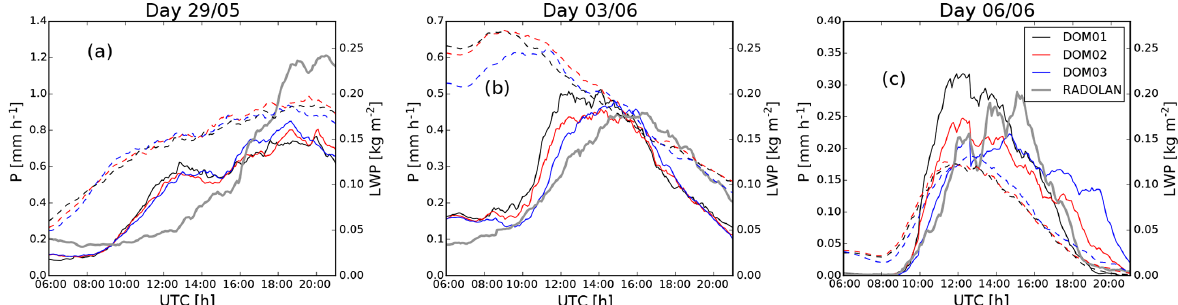
Figure 2. Time series of the mean precipitation intensity P (solid lines, left axes) and liquid water path LWP (dashed lines, right axes), for the 3d 29 May (a) , 3 June (b) , and 6 June (c) , for all three domains with 625m (DOM01), 312m (DOM02), and 156m (DOM03) grid spacing. The gray thick line shows the RADOLAN derived precipitation intensity. Averaging was carried out over all grid boxes where radar data are available.